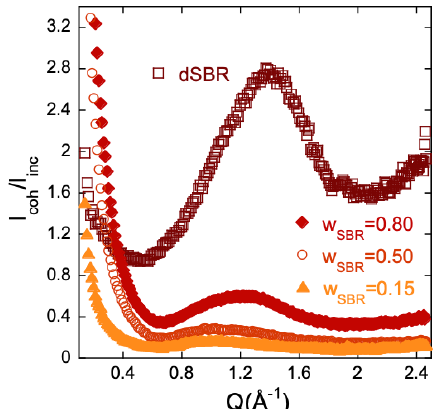
Fig. 3. Ratio between the coherent and incoherent differential scattering cross-sections determined by diffraction with polarization analysis (D7) on the pure dSBR system and blend samples with different